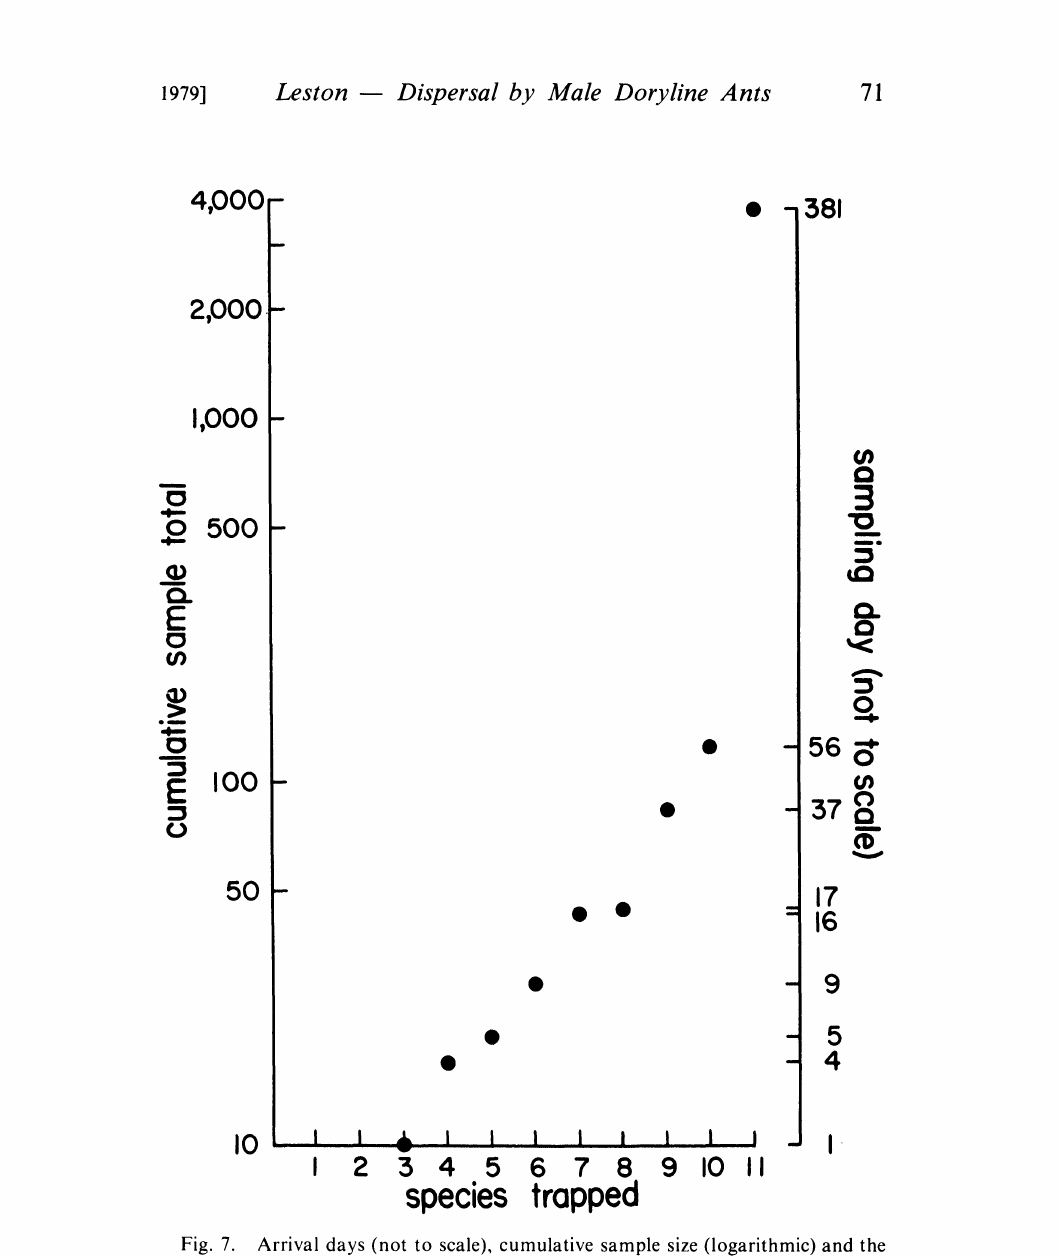
Fig. 7. Arrival days (not to scale), cumulative sample size (logarithmic) and the cumulative species